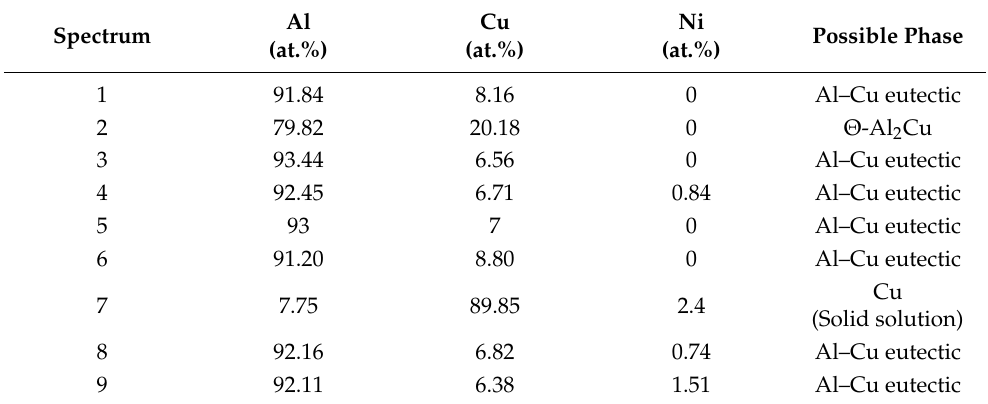
Figure 10. SEM/EDS line scan of region C in Figure 9 (power = 1500 W, welding speed = 30 mm/s).; (C) is the magnified SEM image of location C in weld fusion zone in Figure 9